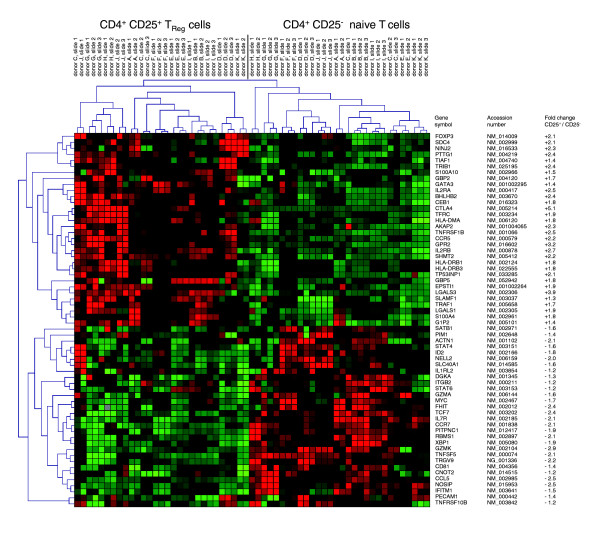
Transcriptional profiling of CD4+CD25+ TReg and CD4+CD25- naïve T cells. To identify molecular differences between regulatory and naïve human T cells, differential expression of 350 genes was investigated by application of our Human TReg Chip. Following data normalization, Statistical Analysis of Microarrays (SAM) was applied as a data mining tool to ascertain gene expression changes, identifying 62 significantly altered genes between both T cell subpopulations (delta = 2.46, median FDR [false discovery rate] = 0.48). After entering the generated data set into Genesis software, a two-dimensional hierarchical clustering analysis yielded the displayed transcriptional pattern, which discriminates between human regulatory and naïve T cells, and consists of 32 upregulated and 30 downregulated genes. Each row represents a gene probed on the Human TReg Chip; each column shows expression of the 62 genes measured for each individual in the study. Red indicates genes that are expressed at higher levels compared with the mean signal intensities of all experiments, whereas downregulated genes are colored in green and black indicates signal intensities near the mean expression level.